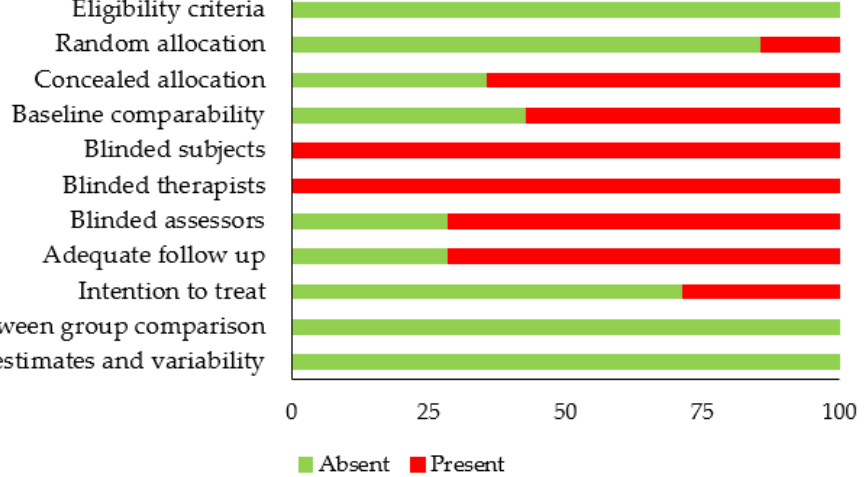
Figure 2. Risk of bias according to the PEDro scale (Absent: Risk of bias absent, Present: Risk of bias present).